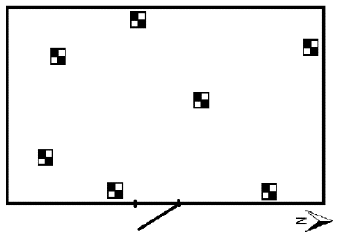
Figure 3. Plan of the location of calibration disks in measured room